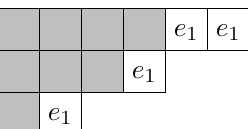
Figure 2. The relationship between Young diagrams of m d and m d − 1 . The boxes which belong to m d − 1 are